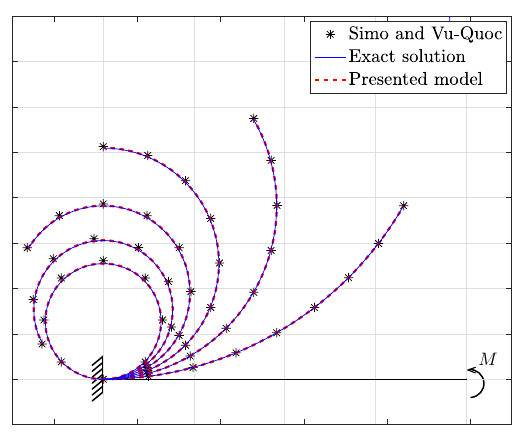
Figure 4. Close-up view of the solution at the end of the sixth step using 6,10,20, and 50